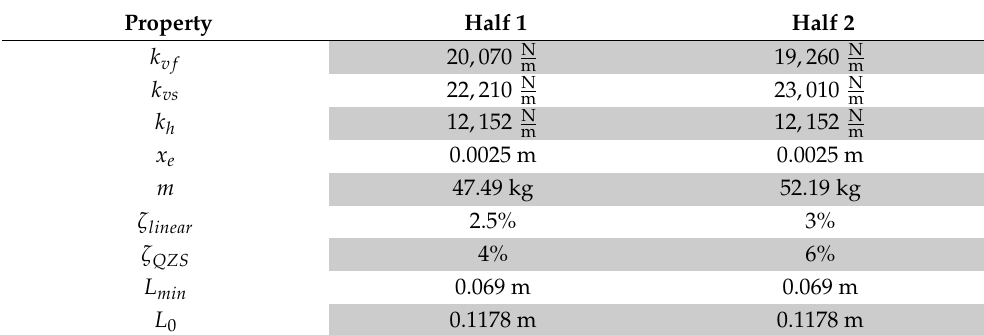
Table 1. Prototypes 1 and 2 physical properties. K vf refers to the vertical stiffness of the springs within the first half of the force–displacement plot. K vs refers to the stiffness within the second part of the plot. Refer to experimental procedures below for more